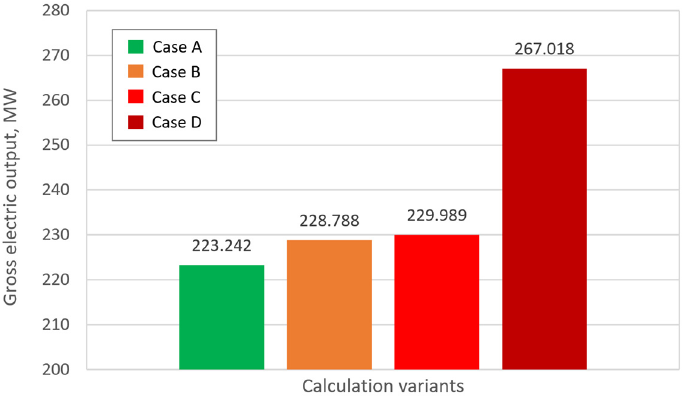
Figure 12. Gross electric power output for different parameters of steam feeding the turbine.